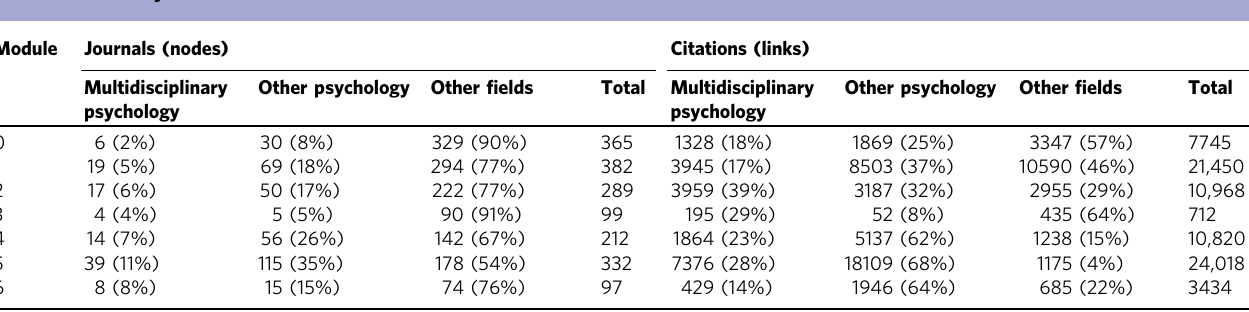
Table 2 Summary statistics for each module in the 2008 citation